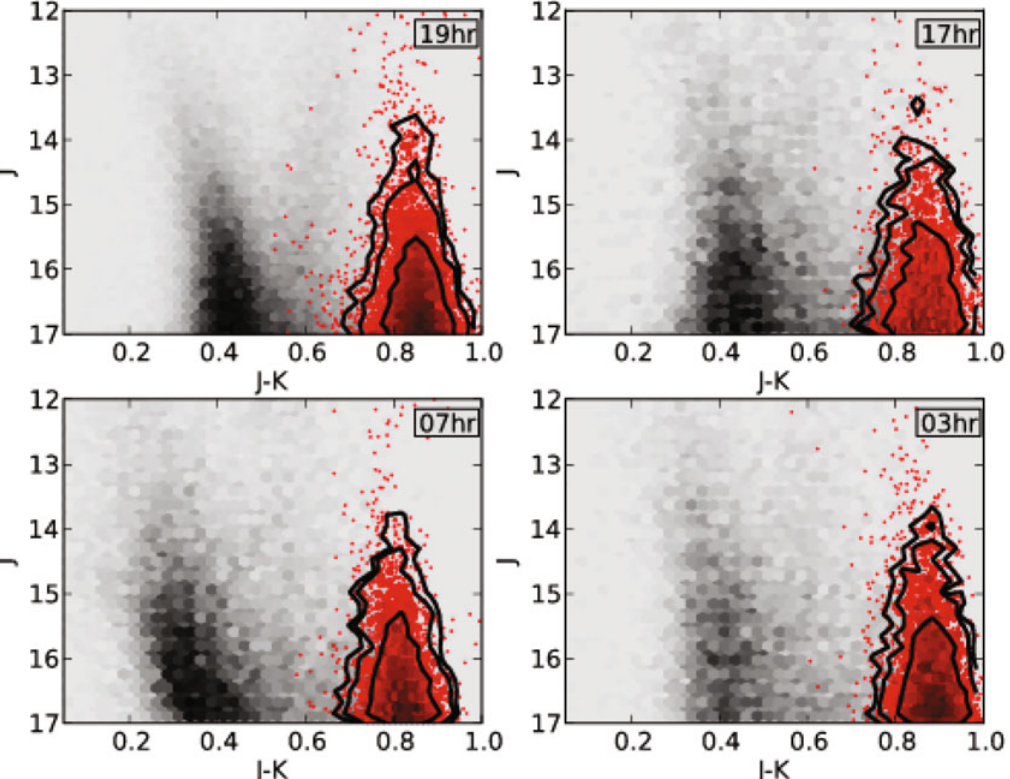
Figure 3. Colour-magnitude diagram for all the four WTS fields, red points are the selected M dwarf stars. Contours of 68%, 90% and 95% of the M dwarfs are shown for each